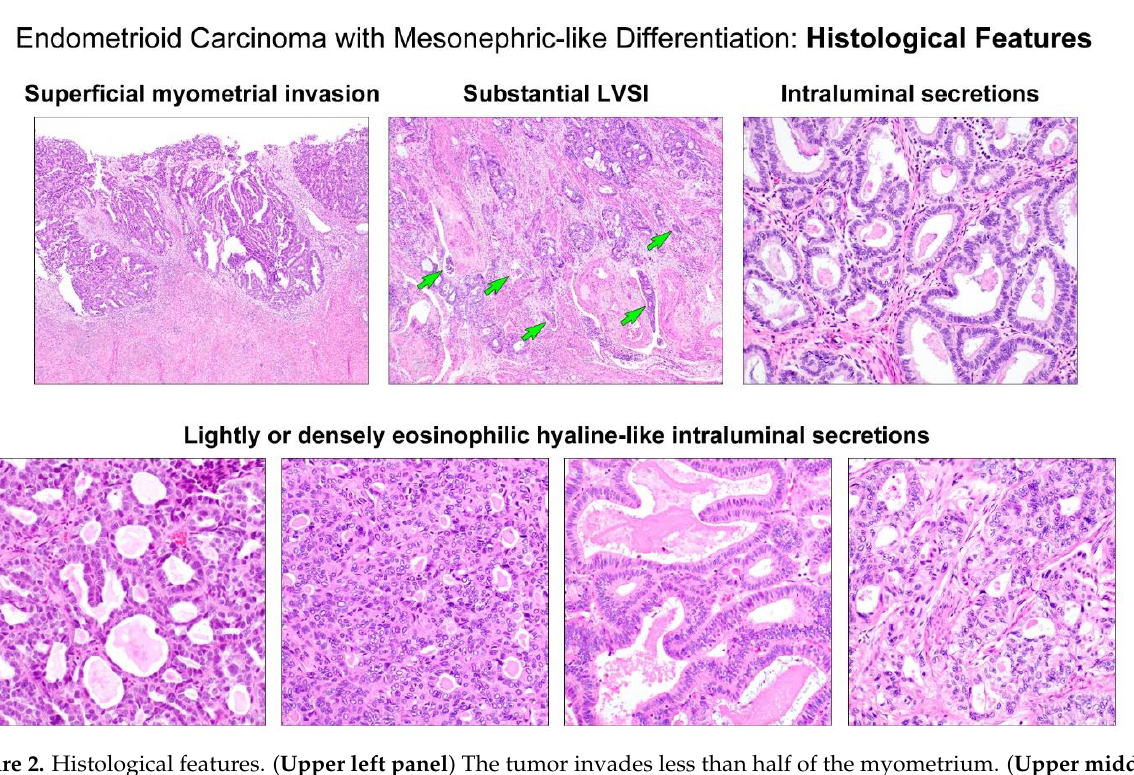
Figure 2. Histological features. ( Upper left panel ) The tumor invades less than half of the myometrium. ( Upper middle panel ) The invasive front displays substantial lymphovascular space invasion (LVSI; green arrows). ( Upper right panel ) The tubules and glands possess eosinophilic secretions. ( Lower panels ) Variable-shaped tubular and glandular lumina are filled with lightly or densely eosinophilic intraluminal hyaline-like secretions, characteristic of uterine mesonephric-like adenocarcinoma.